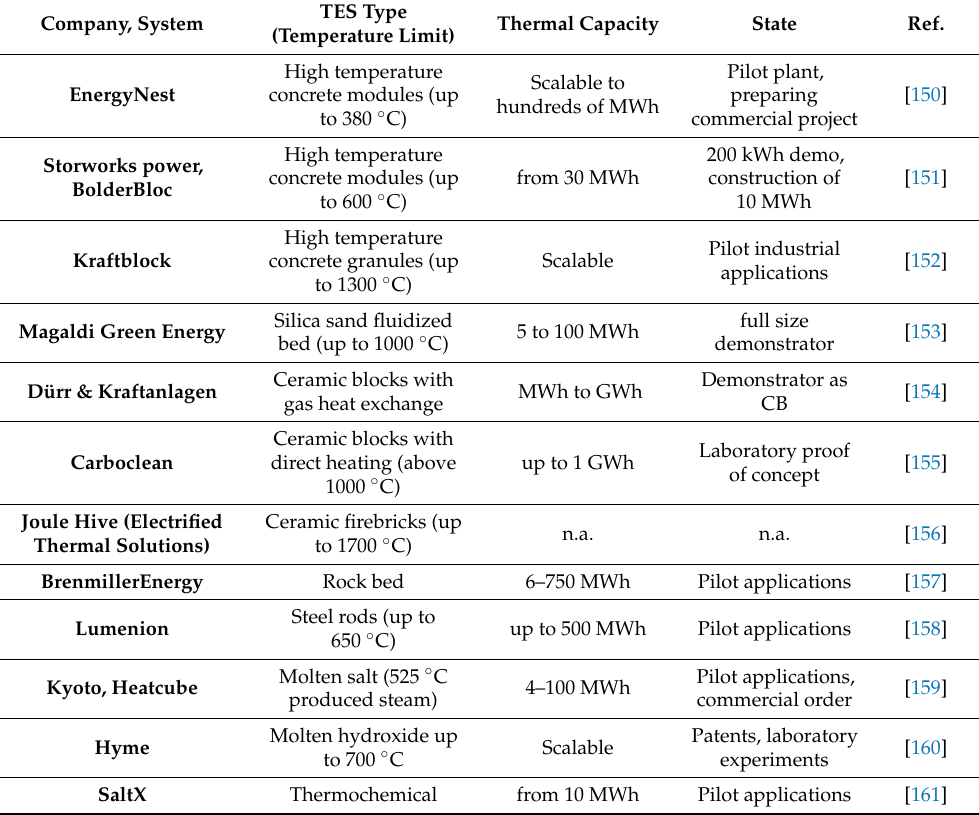
Table 4. Overview of the TES systems for Carnot battery